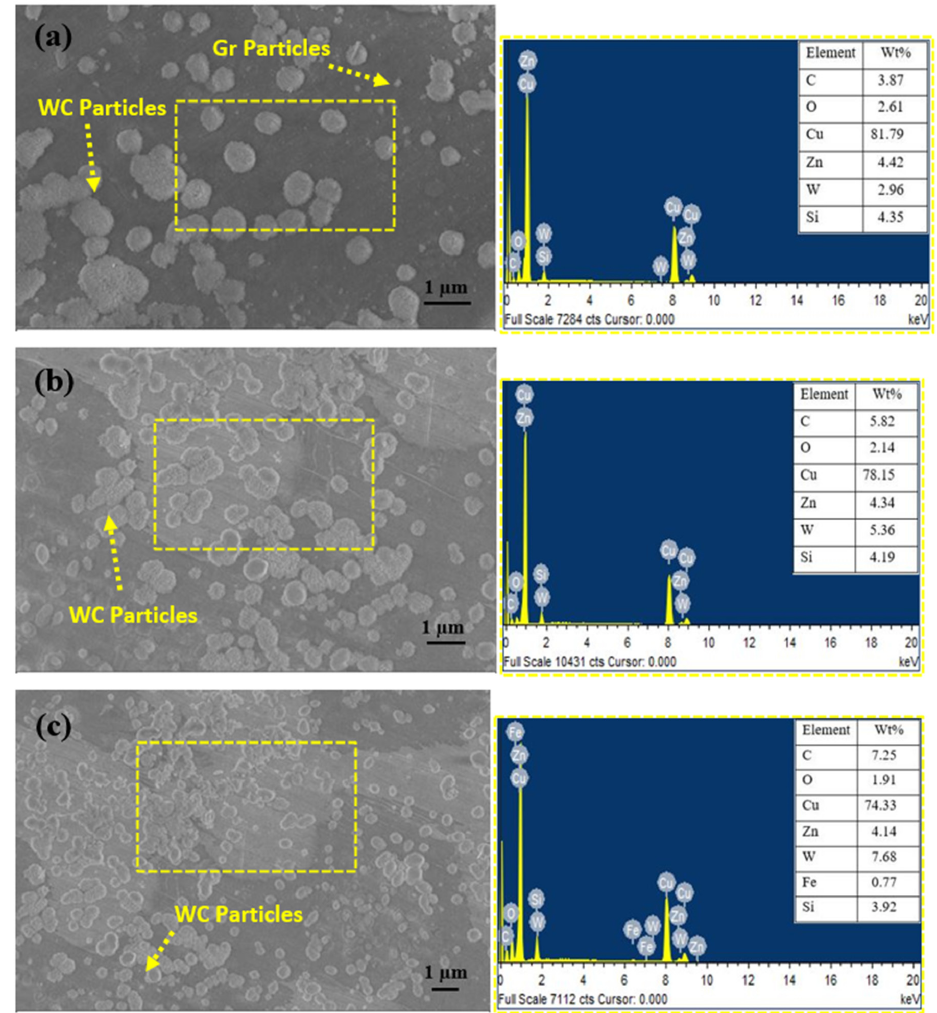
Figure 6. FESEM micrograph and EDX analysis of Cu-SiC-Gr hybrid composites with WC variation of ( a ) 3, ( b ) 6, and ( c ) 9 wt.%.